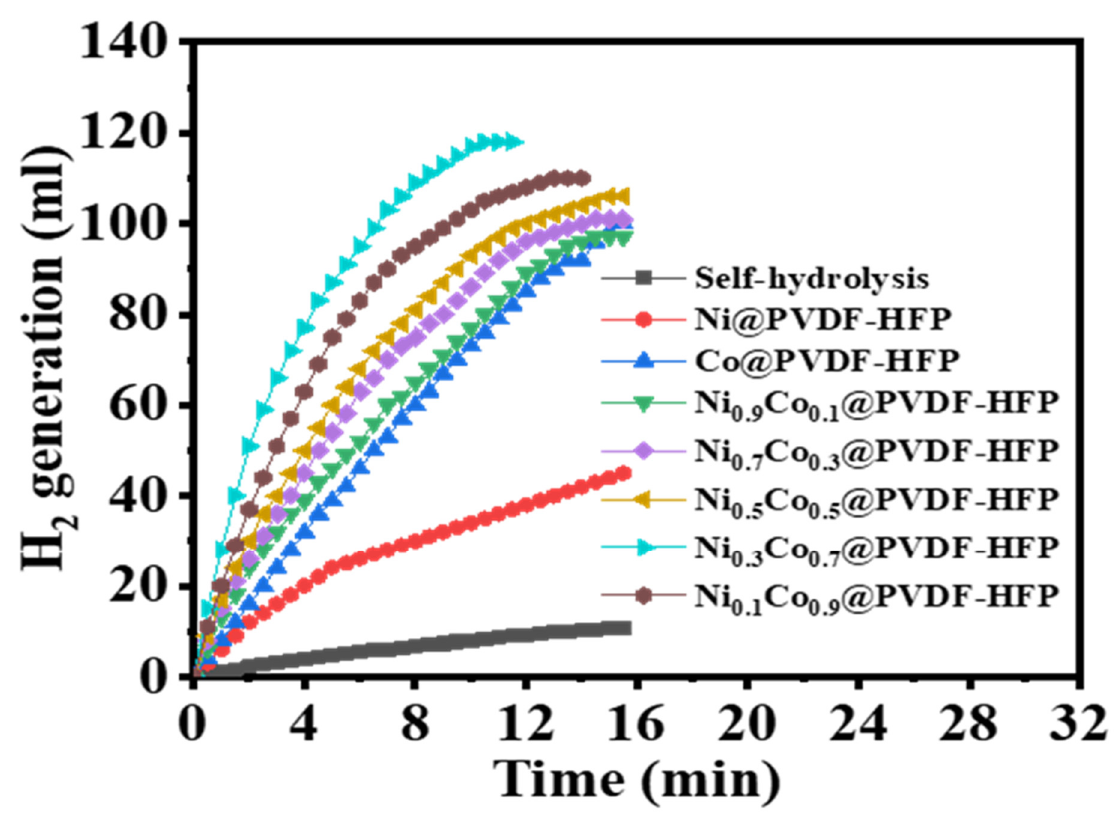
Figure 6. Effect of Ni x Co 1 − x @PVDF-co-HFP NFs on the dehydrogenation of SBH. [Quantity of catalyst = 100 mg, [SBH] = 1 mmol, and T = 298 K].